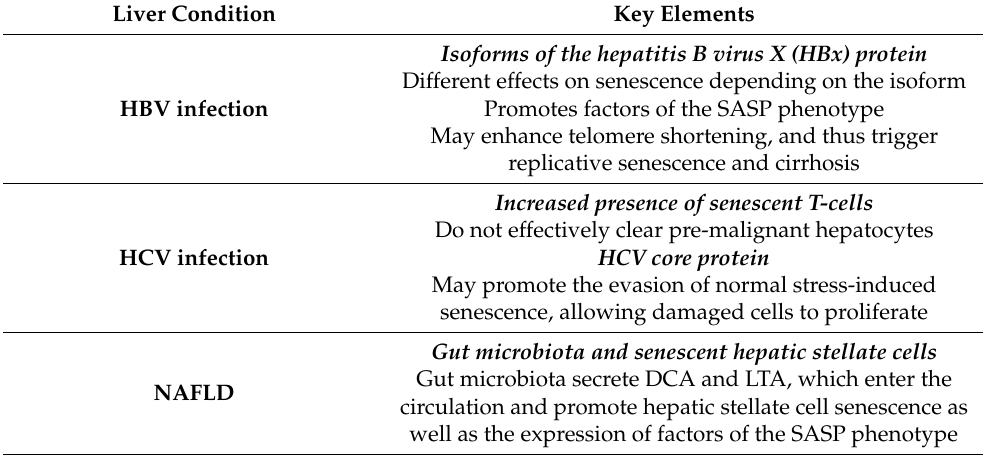
Table 1. Contribution of senescence in HBV-, HCV- and NAFLD- mediated HCC: Key